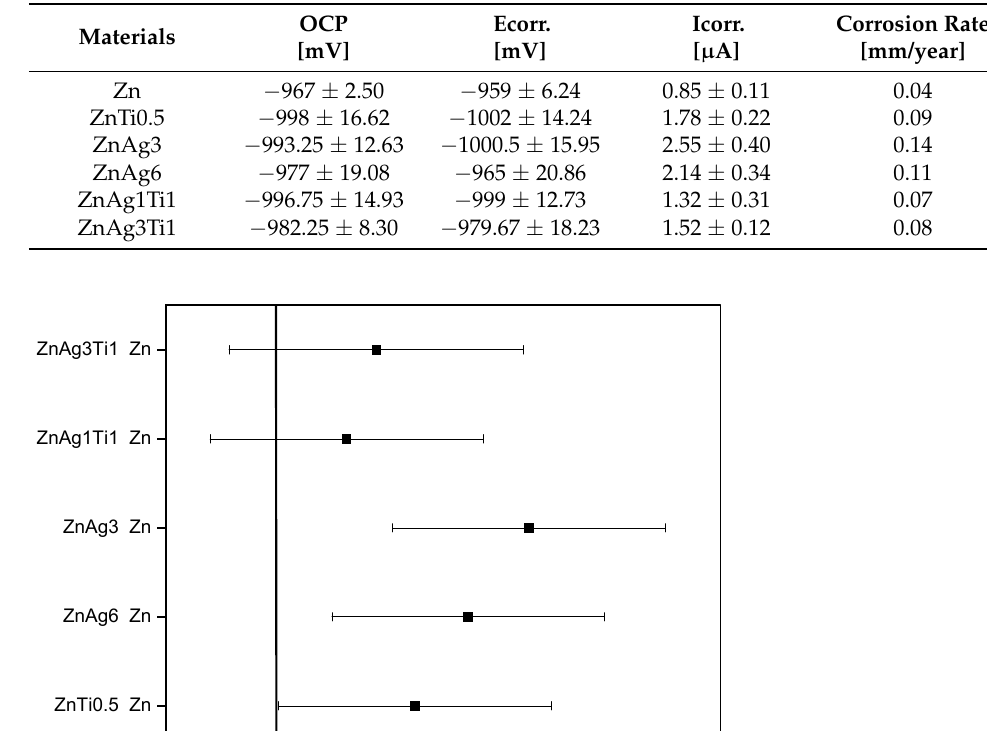
Table 3. Measurements of the corrosion testing with mean and standard deviation.